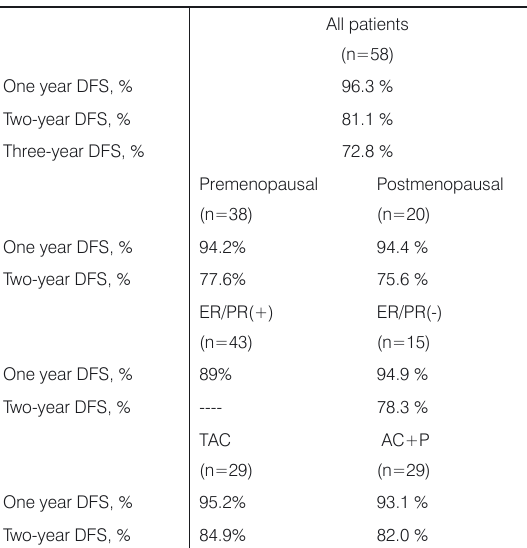
Figure 1. DFS by menopausal status. Table 2. Disease free survival (DFS) data of